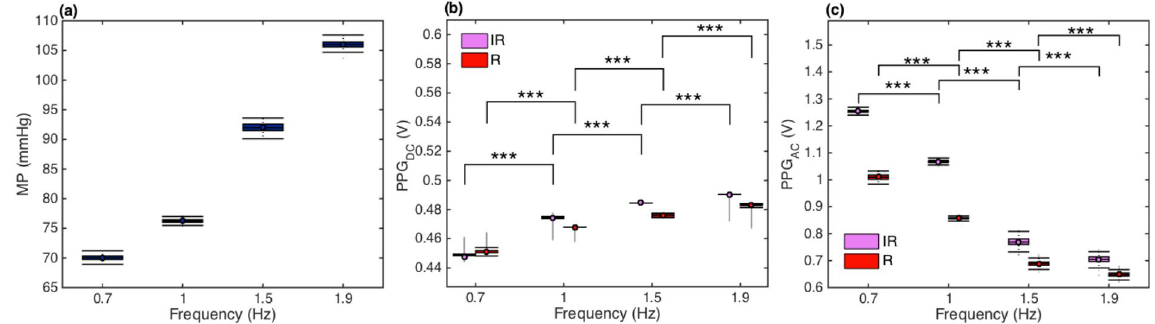
Figure 4. Boxplots for pressure and PPG components. Signals were obtained at varying pumping frequencies while circulating whole equine blood in a pulsatile laminar flow at a stroke volume of 70. ( a ) Mean pressure values, ( b ) R and IR PPGDC levels, ( c ) R and IR PPGAC amplitudes. P-values obtained from multiple Sidak’s test are displayed using the 3-star system. n = 760.